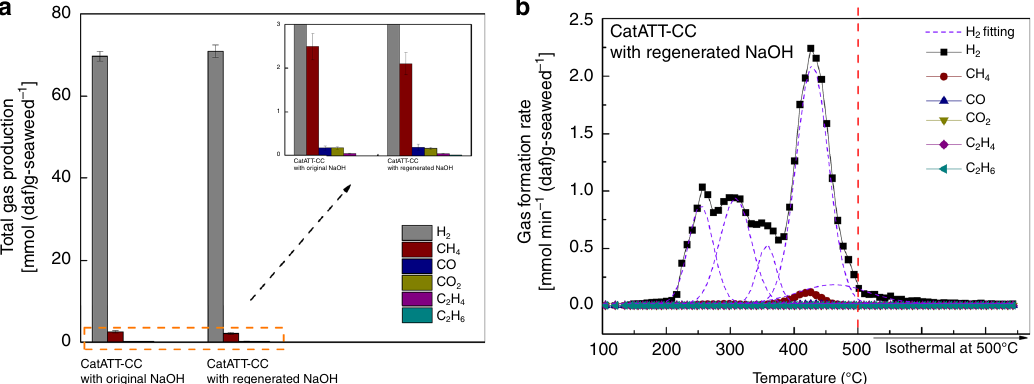
Fig. 6 Recyclability of NaOH during the CatATT-CC reaction of brown seaweed. a Major gaseous products generated via CatATT-CC reactions performed using fresh NaOH and regenerated NaOH (at 500 °C and 1 atm under a steam atmosphere). b Gas formation behaviors in the CatATT-CC reaction of seaweed using regenerated